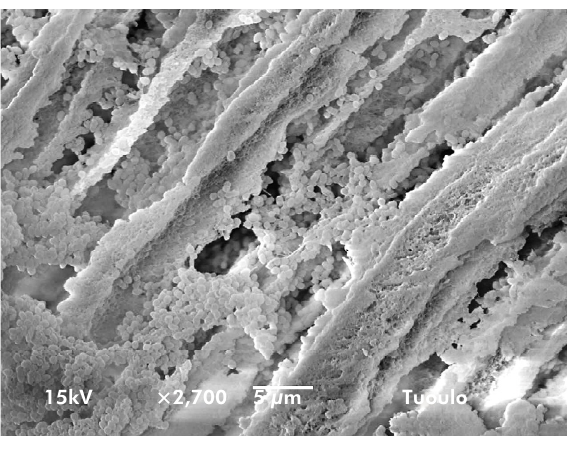
Figure. Scanning electron microscopic image of Enterococcus faecalis biofilm formation in the root canal walls and within the dentinal